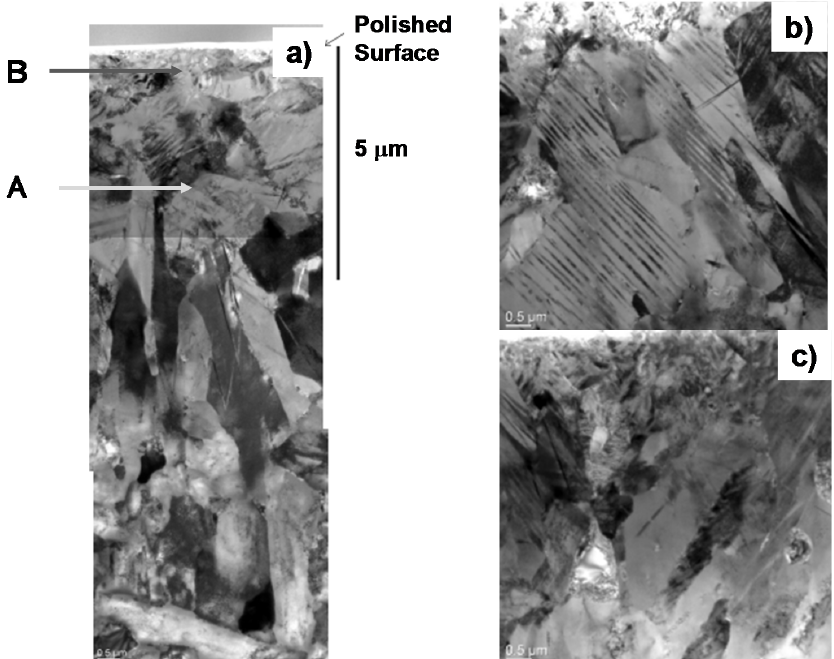
Figure 8. TEM image at the vicinity of the polished surface down to d = 10 µ m; ( a ) overall crystallographic structure down to the depth of 10 µ m; ( b ) microstructure at point A in the heterogeneously nitrided layer; ( c ) microstructure at point B in the transient to the homogeneously nitrided layer.